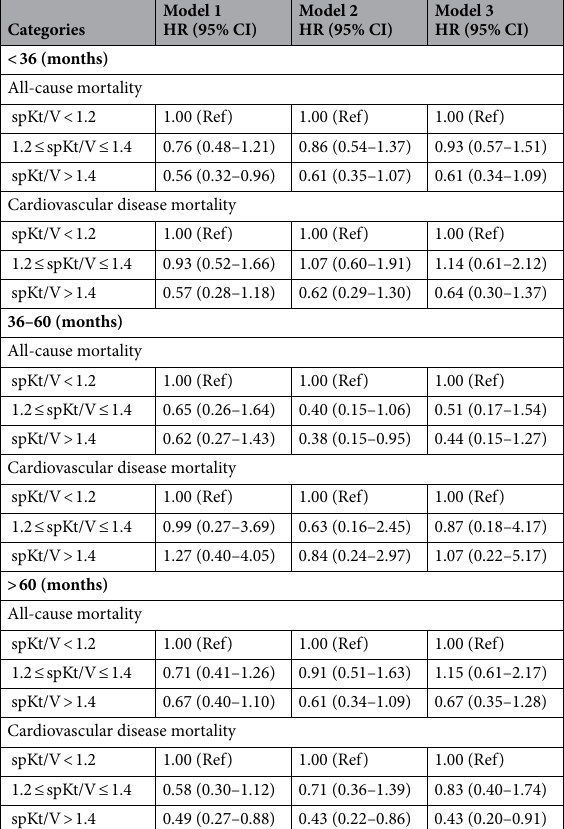
Table 4. Hazard ratios (95% CI) for the association between dialysis dose and all-cause and cardiovascular disease mortality by duration of dialysis. CI confidence interval, HR hazards ratio, Ref reference. a Model 1: Crude model. b Model 2: Adjusted for age and gender. c Model 3: Adjusted for age, gender, heart failure, hemoglobin, albumin, creatinine, total cholesterol and primary